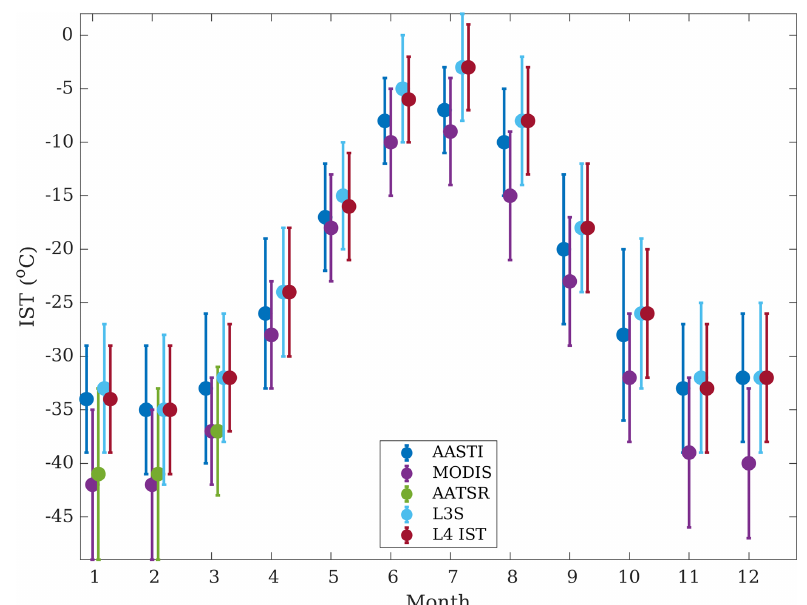
Figure 4. Mean monthly IST (dots) and its standard deviation (bars) over the Greenland Ice Sheet from the L3 AASTI, L3 MODIS, L3 AATSR, and derived L3S and L4 IST products, when available.